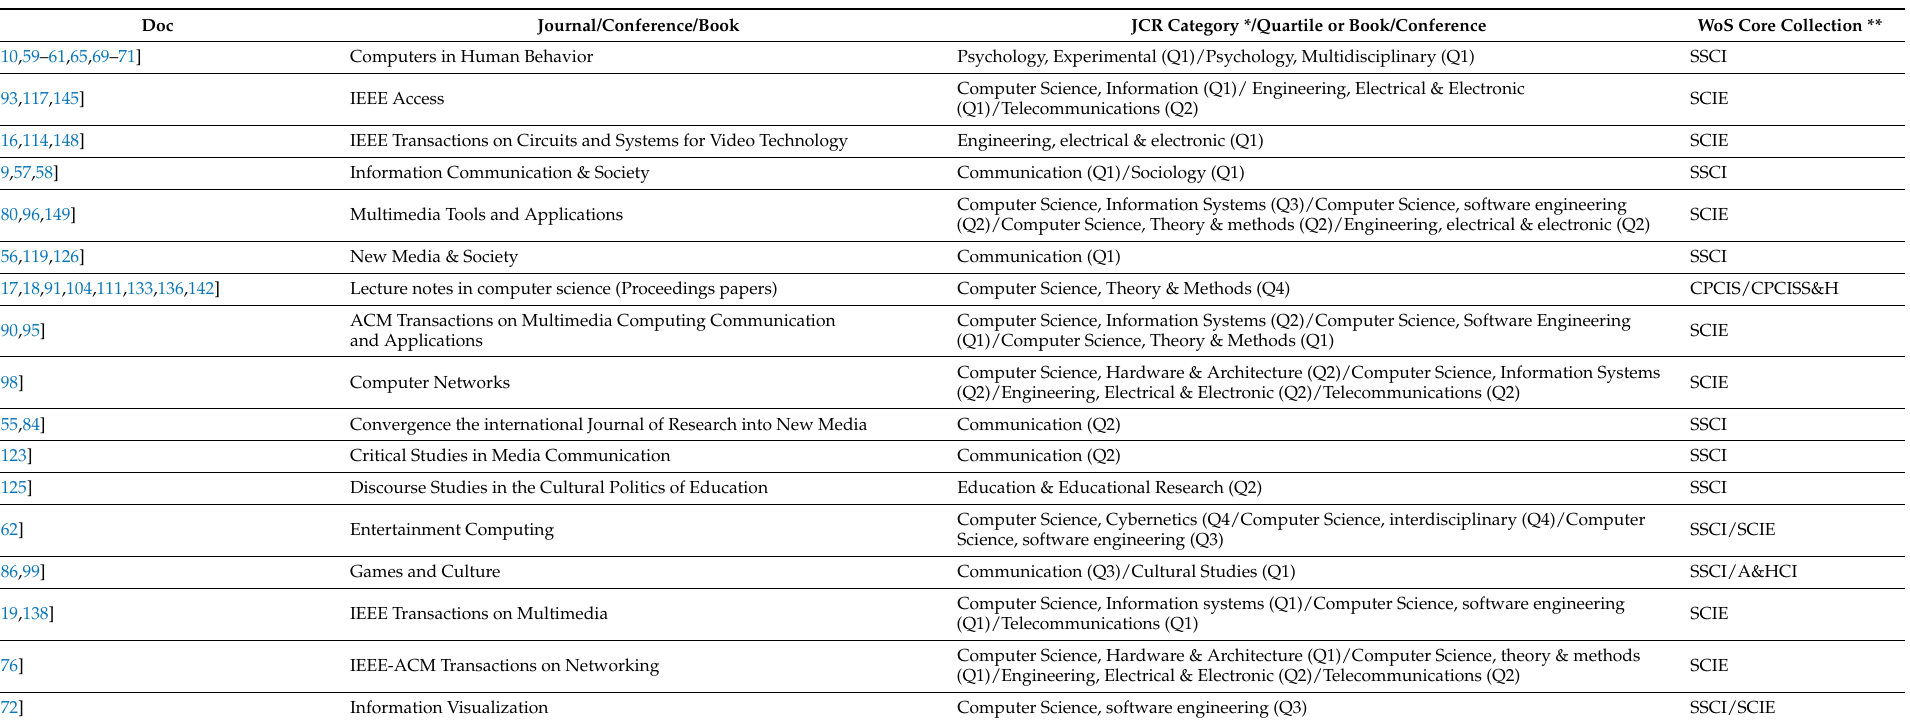
Table A2. Journal of publication, journal quartile and citation index in Web of Science (WoS) core